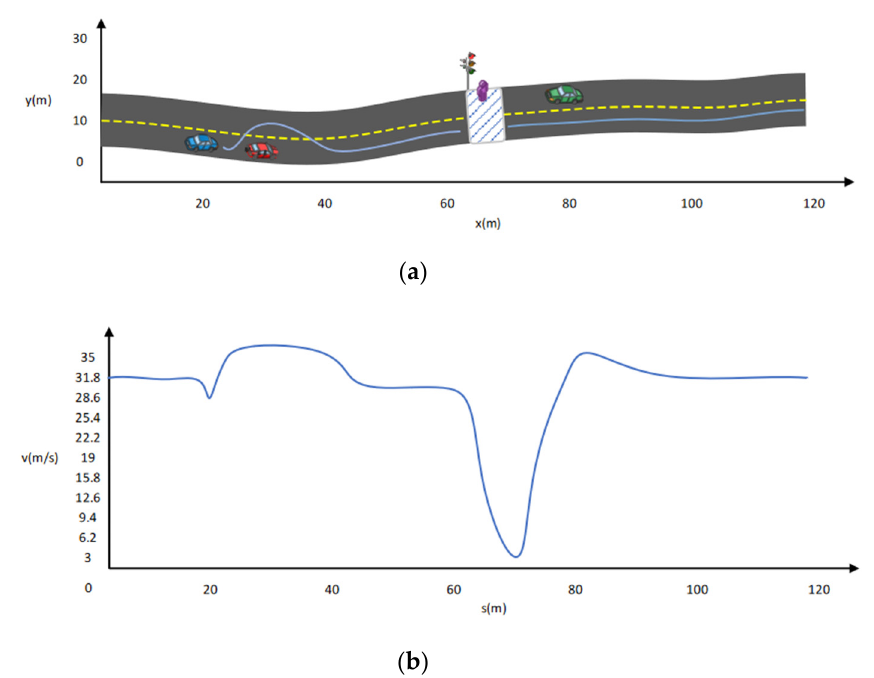
Figure 9. Dynamic path planning results in a straight road with multiple challenges. ( a ) Vehicle overtakes the vehicle in front and waits for the green signal, ( b ) Speed Curve.